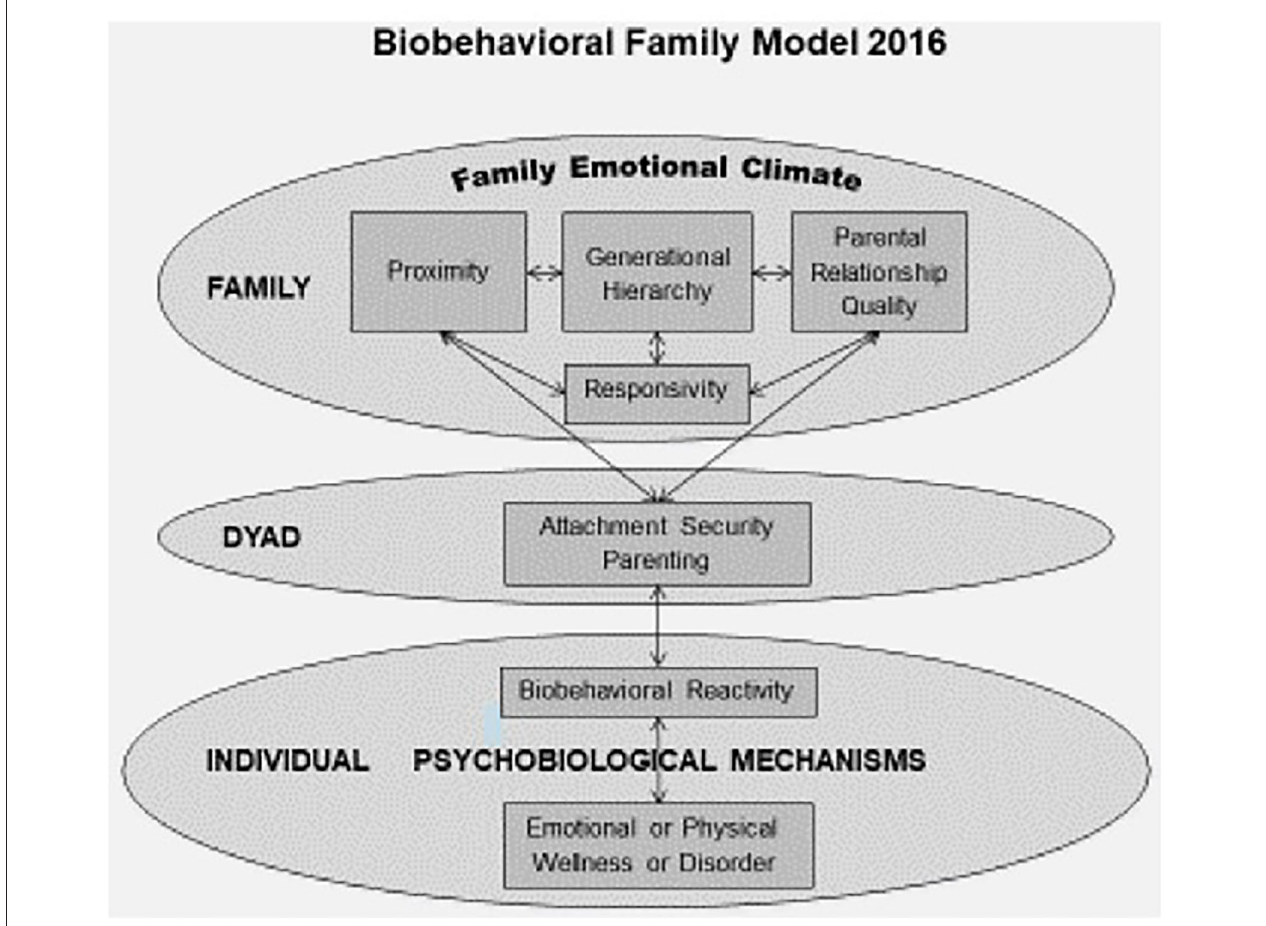
FIGURE 2 | The biobehavioral family model